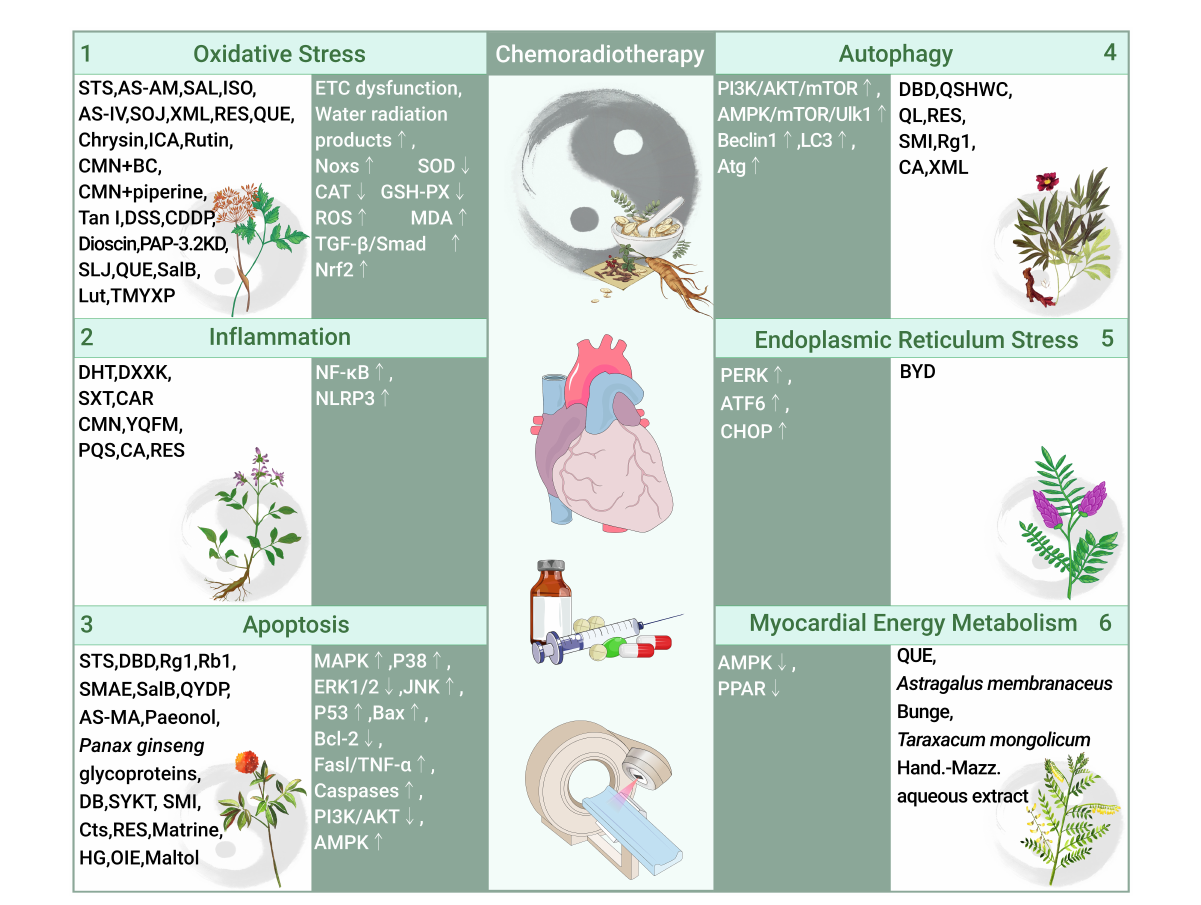
FIGURE1 Role and molecular mechanism of traditional Chinese medicine in preventing cardiotoxicity associated with chemoradiotherapy (traditional Chinese medicine alleviates chemoradiotherapy-related cardiotoxicity by inhibiting oxidative stress, anti-inflammatory, regulating apoptosis and autophagy, inhibition of endoplasmic reticulum stress, and improves myocardial energy metabolism. OS, Oxidative stress; Noxs, NADPH oxidases; SOD, Superoxide dismutase; CAT, Catalase; GSH-PX, Glutathione; ROS, Reactive oxygen species; MDA, Malondialdehyde; TGF- β , Transforming growth factor- β ; Smad, Small Mothers Against Decapentaplegic; Nrf2, Nuclear factor erythroid 2-related factor 2; STS, Tanshinone IIa sodium sulfonate; AS-AM, Angelica Sinensis and Astragalus membranaceus Bunge Ultrafiltration Extract; SAL, Salidroside; ISO, Isoorientin; AS-IV, Astragaloside IV; SOJ, Steroidal saponins extract from Ophiopogon japonicus (SOJ) root; XML, Xinmailong injection; RES, Resveratrol; QUE, Quercetin; ICA, Icariin; CMN, Curcumin; BC, β -carotene; Tan I, Tanshinone I; DSS, Danshensu; CDDP, Compound Danshen Dripping Pill; PAP-3.2KD, Pilose antler Peptide-3.2KD; SLJ, Shenlijia; SalB, Salvianolic acid B; Lut, Luteolin; TMYXP, Tongmai Yangxin Pills; NF- κ B, Nuclear factor kappa-B; NLRP3, Sirtuin1 (Sirt1)-nod-like receptor protein 3; DHT, Dihydrotanshinone I; DXXK, Di’ao Xinxuekang capsule; SXT, Shengxian decoction; CAR, Cardamom; YQFM, Yiqi Fumai lyophilized injection; PQS, Panax quinquefolius ; CA, Calycosin; RES, Resveratrol; MAPK, Mitogen-activated protein kinase; ERK, Extracellular signal-regulated kinases; JNK, C-Jun-terminal kinases; Bax, Bcl-2 associated X; Bcl-2, B-cell lymphoma-2; Fasl/TNF- α , Fas ligand/tumor necrosis factor- α ; Caspases, Cysteine aspartate proteases; PI3K/AKT, phosphatidylinositol 3-kinase/serine-threonine protein kinase; AMPK, adenosine monophosphate-activated protein kinase; DBD, Danggui Buxue decoction; Rg1, ginsenoside Rg1; Rb1, ginsenoside Rb1; SMAE, Salvia miltiorrhiza aqueous extract; QYDP, Qishen Yiqi Dropping Pills; DB, Diethyl blechnic; SYKT, Sanyang Xuedai; SMI, Shenmai Injection; Cts, Cryptotanshinone; HG, Higenamine; OIE, Oroxylum; mTOR, Mechanistic Target Of